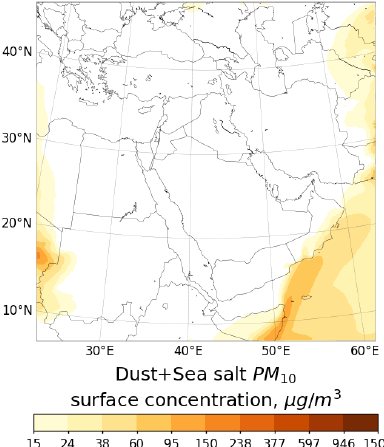
Figure 10. Effect of transboundary transport. Averaged dust and sea salt PM 10 surface concentrations (µgm − 3 ) are obtained from the WRF-Chem simulation without emission of sea salt and